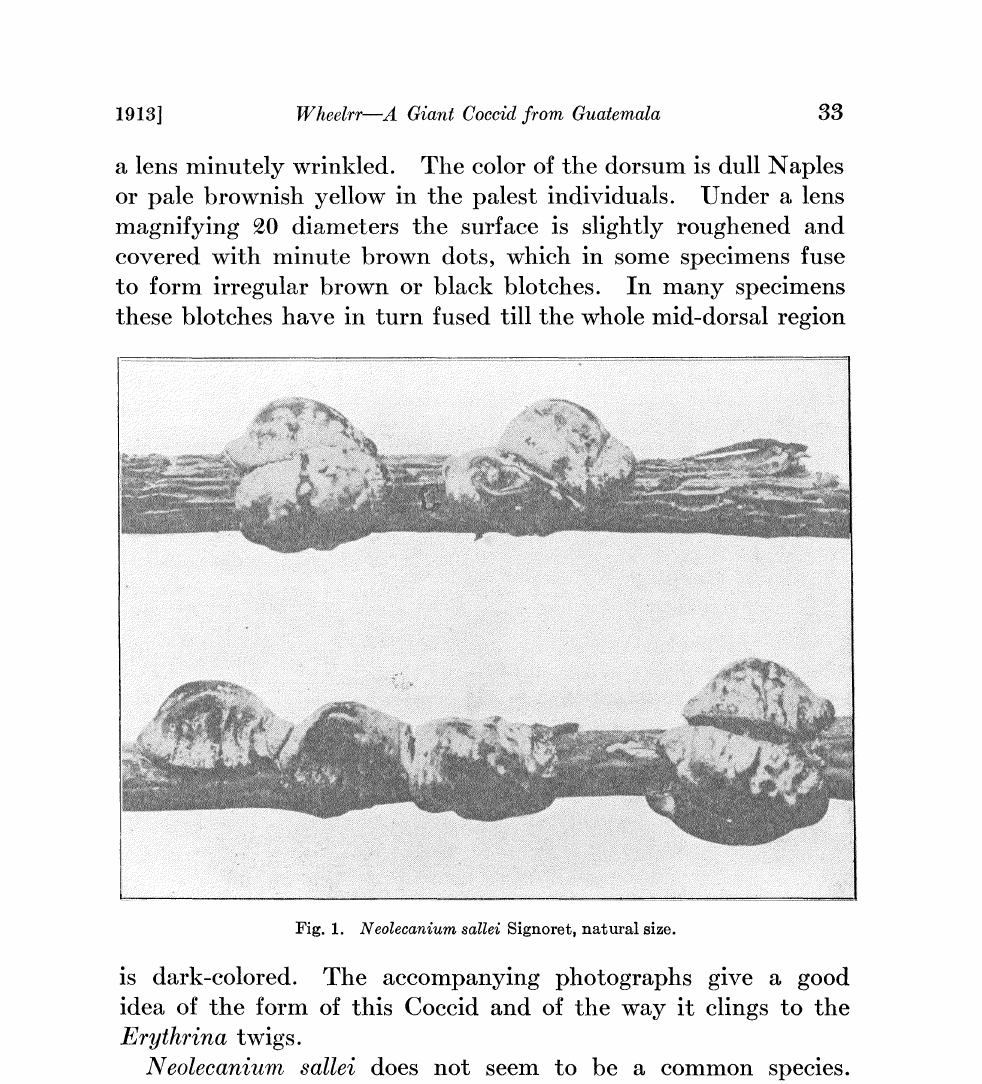
Fig. 1. Neolecanium sallei Signoret, natural size. is